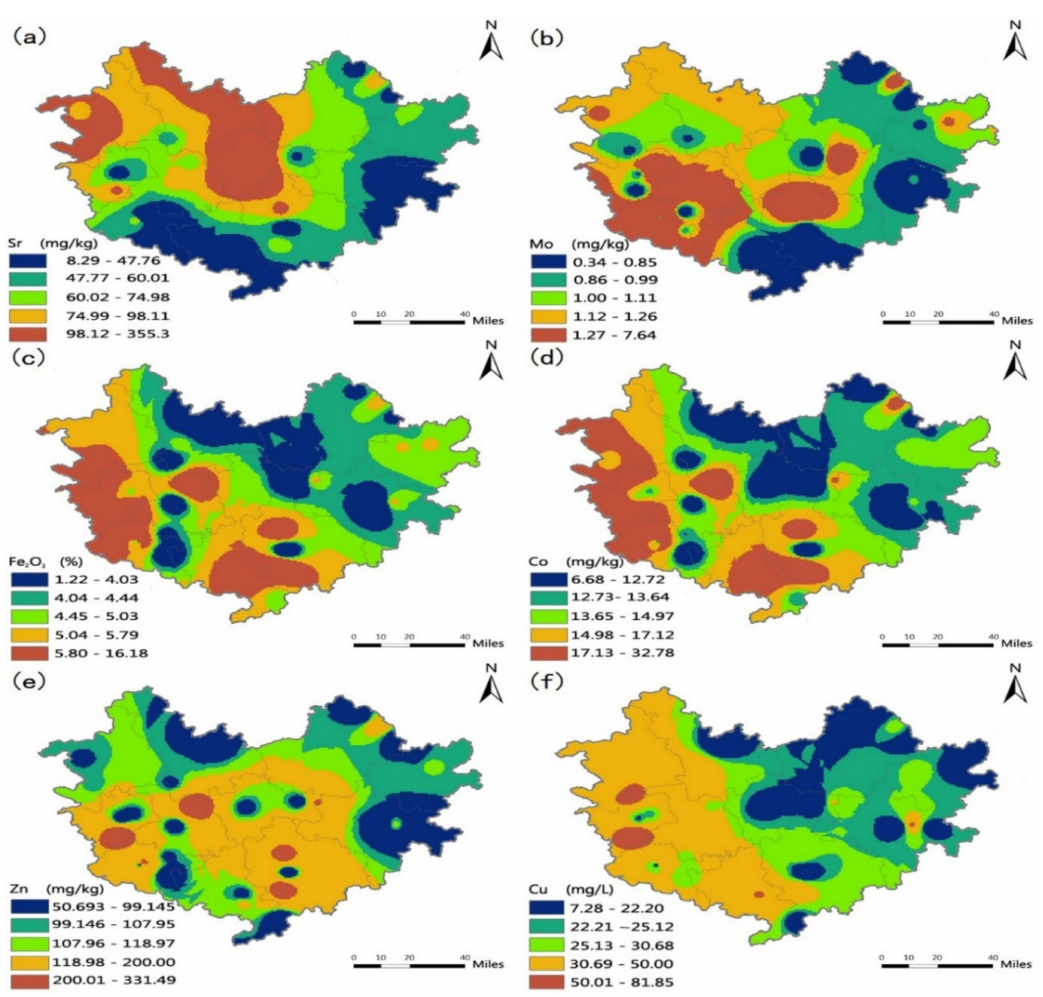
Figure 5. Trace element and mineral levels in soil in Hechi: Sr ( a ), Mo ( b ), Fe 2 O 3 ( c ), Co ( d ), Zn ( e ) and Cu ( f